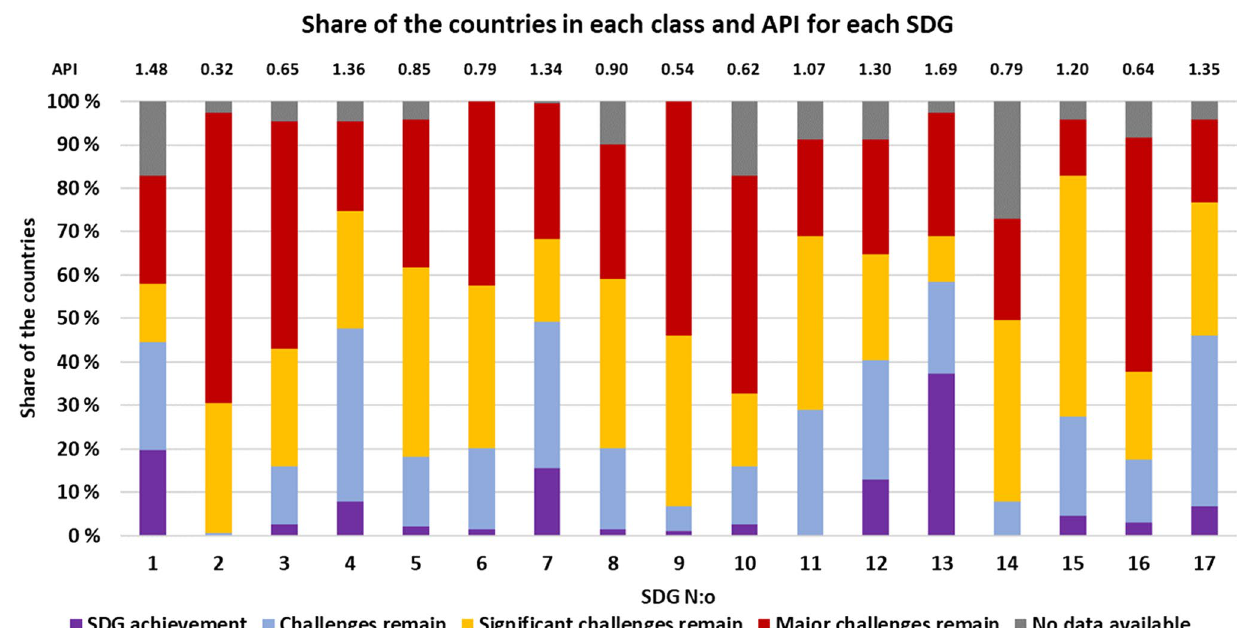
Fig. 3 Distribution of 193 countries into different classes in terms of how they perform in each SDG according to the